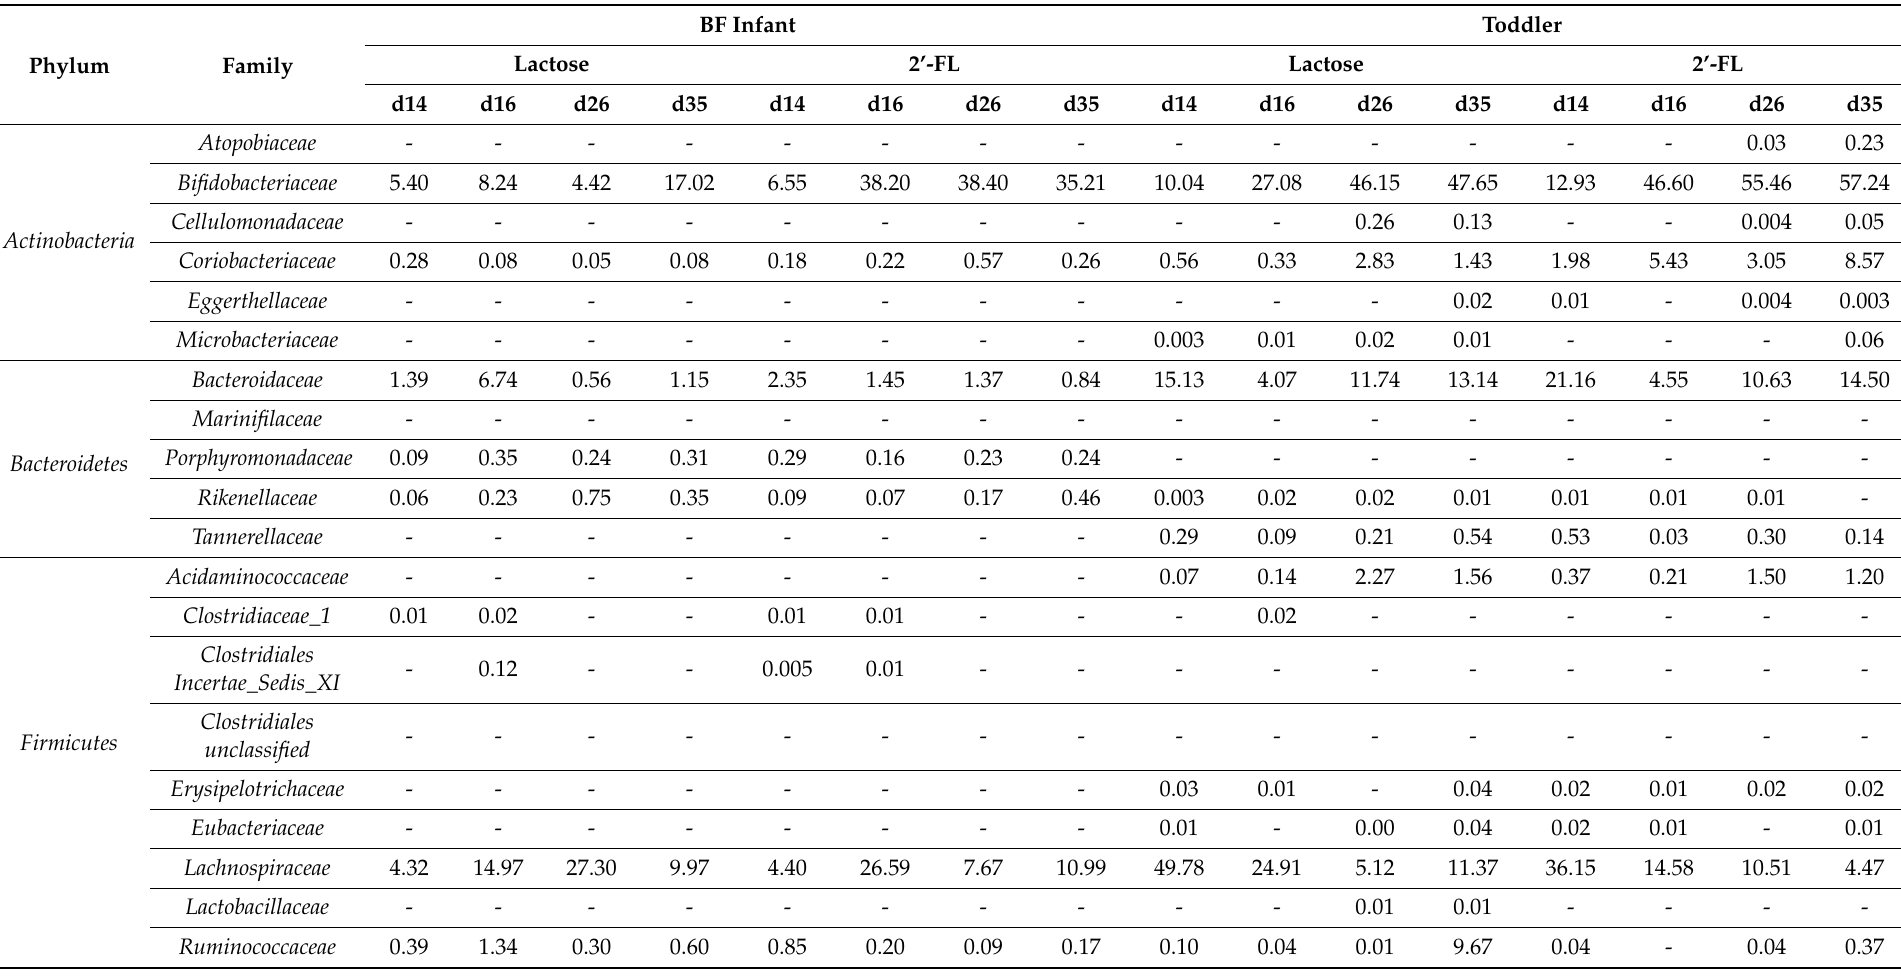
Table 1. Proportional composition at the family level (%) as determined via 16S-targeted Illumina sequencing in the lumen of the proximal colon of the M-SHIME ® inoculated with BF infant or toddler fecal samples (before [d14] and after [d16, d26, and d35] treatment with lactose or 2’-FL) ( n = 1).